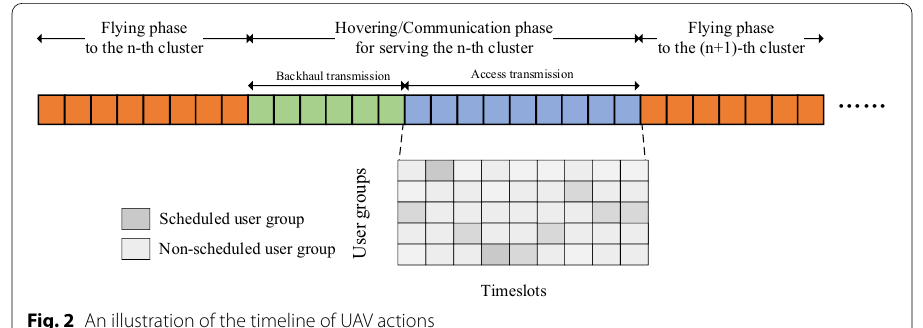
Fig. 2 An illustration of the timeline of UAV